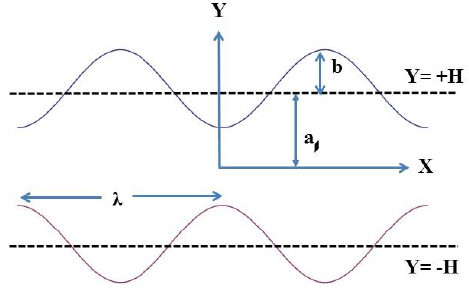
Figure 1. Geometry of the problem.